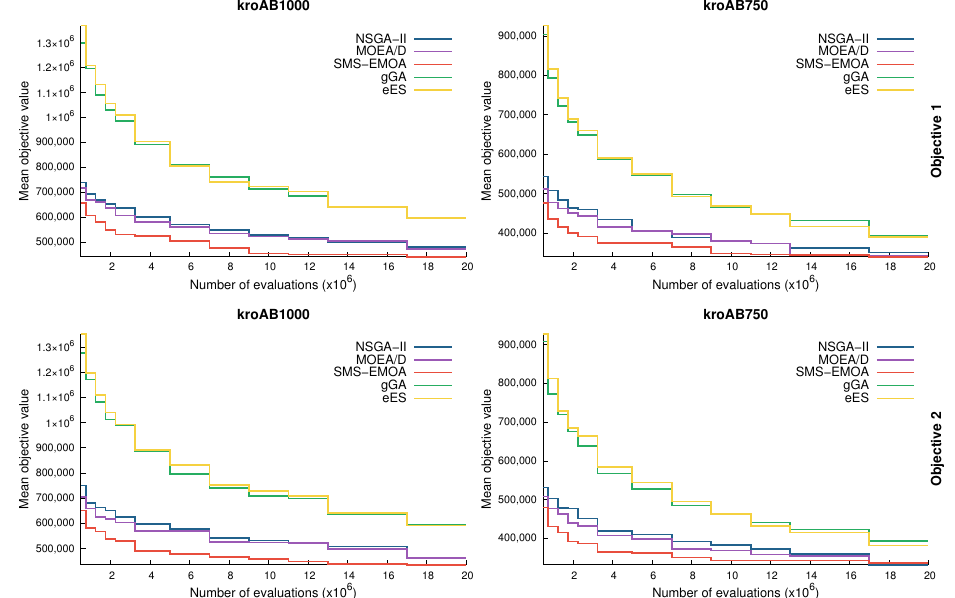
Figure 4. TSP (large instances) evolution of the mean fitness for objectives 1 and